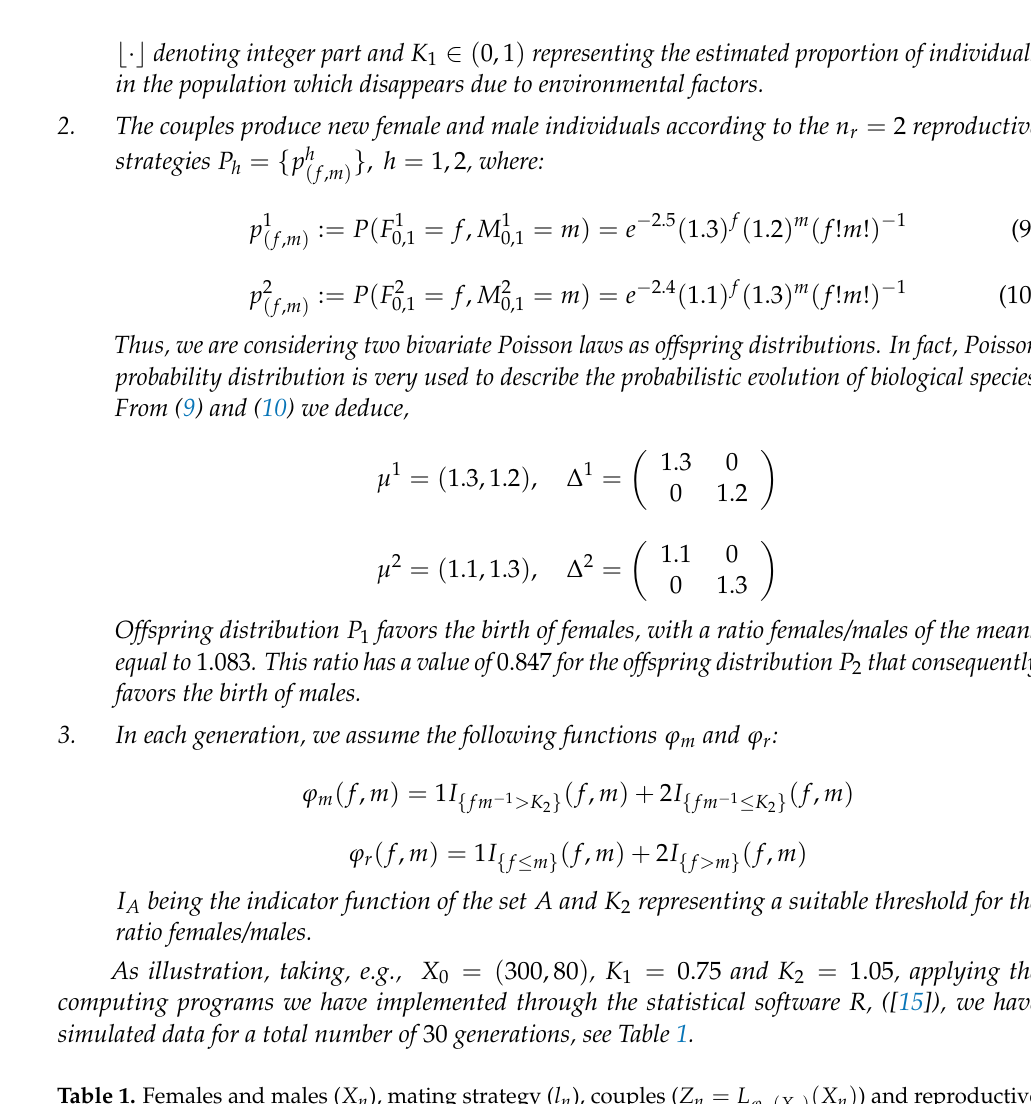
Table 1. Females and males ( X n ), mating strategy ( l n ), couples ( Z n = L ϕ strategy ( h n ) in the successive